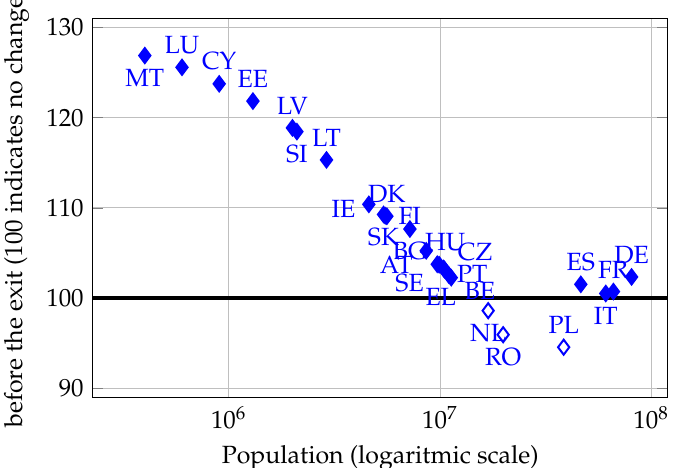
Figure 5. Effect of Brexit before Croatia joined the EU with populations for 2015, adjusted Shapley– Shubik